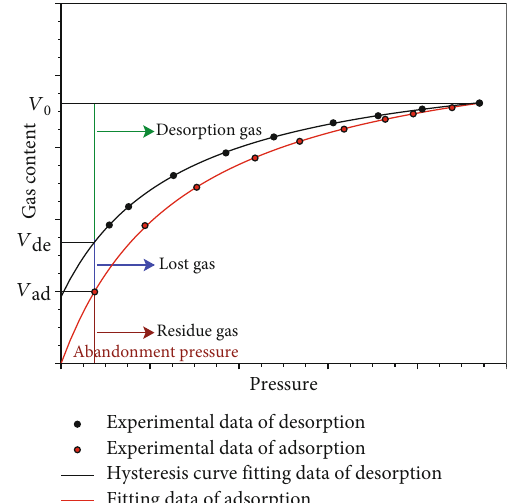
Figure 2: Illustration of adsorption/desorption hysteresis evaluation